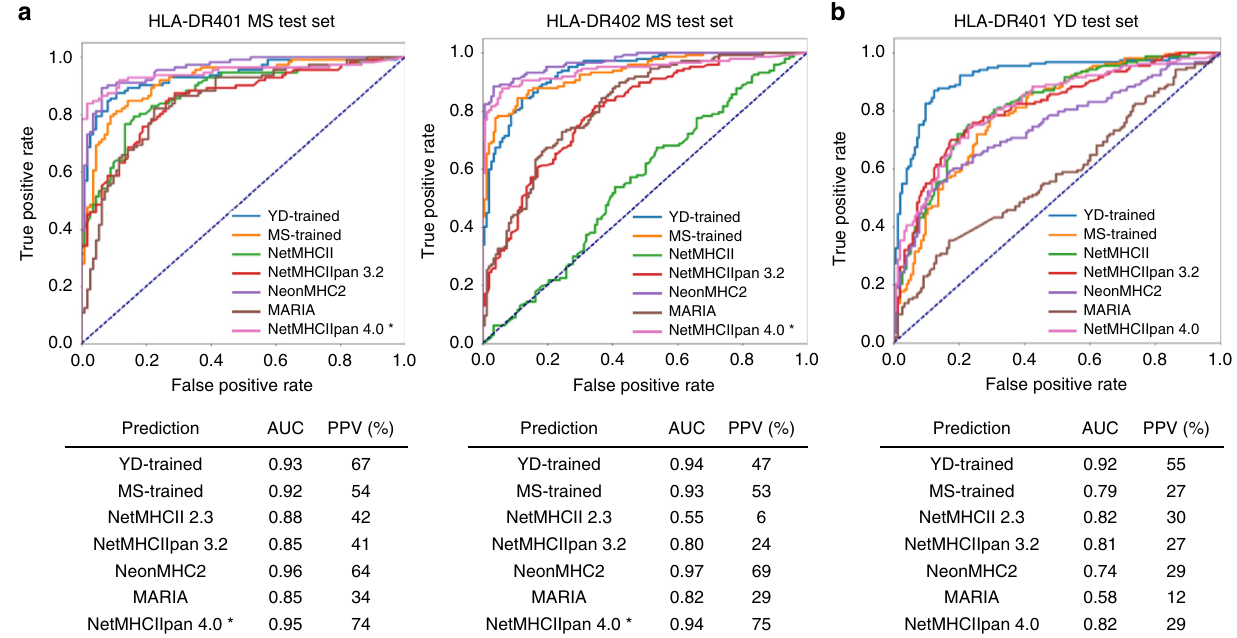
Fig. 6 Benchmarking performance of yeast-display-trained algorithms. Receiver operating characteristic (ROC) curves for prediction with existing prediction algorithms, or algorithms trained on our 9mer yeast-display library (YD-trained) or eluted ligand mono-allelic mass spectrometry (MS-trained) data, on either a outlier-removed eluted ligand MS data for HLA-DR401 and -DR402, with expression-matched decoy peptides, or b yeast-display 13mer HLA-DR401 library data, with naïve library decoys. For each dataset, the area under the ROC curve (AUC) and positive predictive value (PPV) of each prediction are shown. Asterisks indicate algorithms that contain the evaluation set in their training data. Source data are provided as a Source Data fi